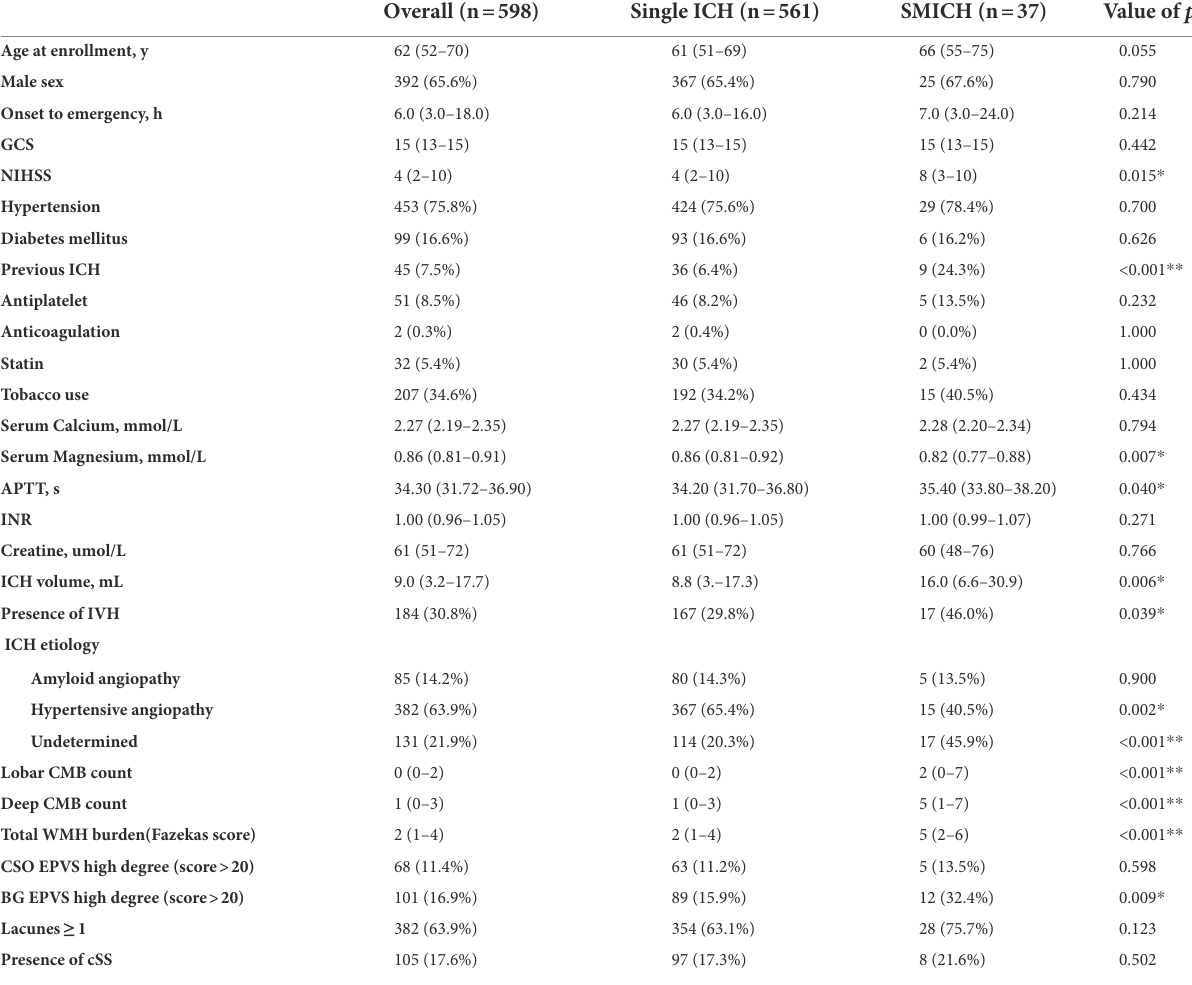
TABLE 1 Baseline clinical, laboratory, and radiological variables of all patients and patients grouped by simultaneous multiple intracerebral